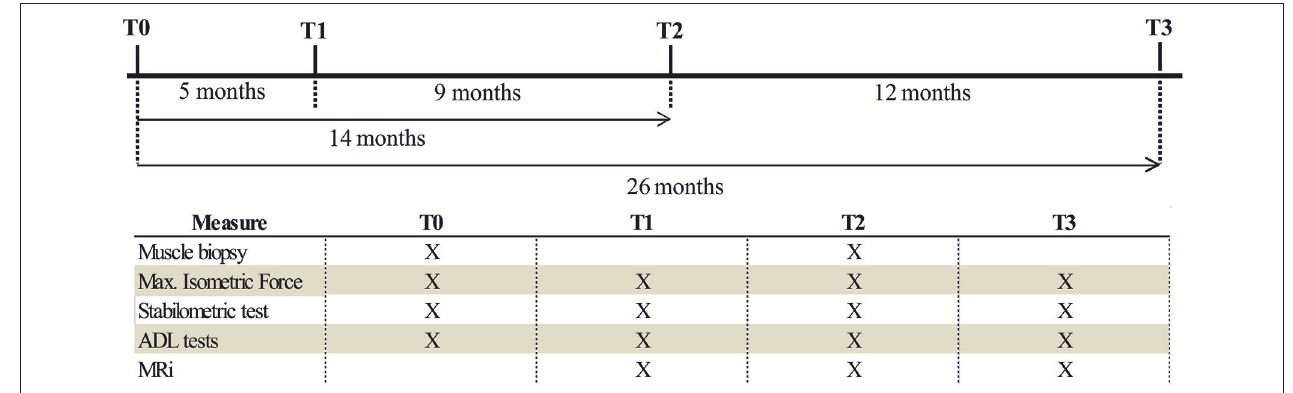
FIGURE 2 | Flowchart of measurement procedure. Flowchart of the measurements performed in each period of the study (T0, T1, T2, and T3).